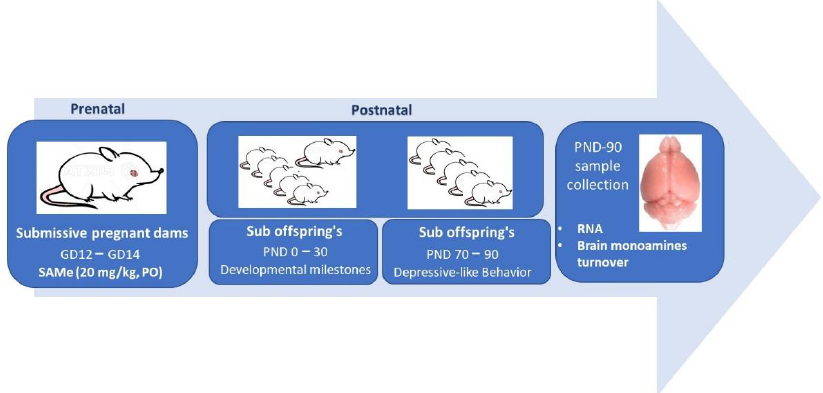
Figure 5. Chart flow describing experimental steps. Brain monoamine levels measurements: At the end of the behavioral evaluations on day 90, mice were killed by exposure to CO2 and their Prefrontal cortex (PFC) was col- lected, frozen in liquid nitrogen and stored at −8 0 C for the study of monoamines and gene expression. We did not study the PFC of the wild type Sabra mice, as Sub offspring treated with SAMe were compared to Saline treated Sub mice. Dopamine (DA) and its metabolites, 3,4-dihydroxyphenylacetic acid (DOPAC), homovanillic acid (HVA); seroto- nin- a 5-hydroxytriptamine (5-HT) and its metabolite, 5-hydroxyindoleacetic acid (5- HIAA); norepinephrine (NE) and its metabolite, 3-methoxy-4-hydroxyphenylglycol (MHPG) contents were measured in the brain by using the HPLC ALEXYS neurotrans- mitters analyzer with column acquity UPLC BEH C18, 1.7 µm , 1 × 100 mm (Waters) and electrochemical detector (ECD). For brain monoamines and their metabolites (5-HT, 5- HIAA, NE, MHPG, DA, DOPAC and HVA) analyses, the frozen PFC was prepared ac- cording to the ALEXYS™ neurotransmitter analyzer protocol. Briefly, the tissue samples were homogenized in 0.2 M perchloric acid (0.5 mL/100 mg wet tissue), left in ice for 30 min and centrifuged at 20,000 G for 15 min at +4 °C. The supernatants were filtered (PhenexTM Nylon, 0.45 μm) and adjusted to pH 3.0 with 1 M sodium acetate.